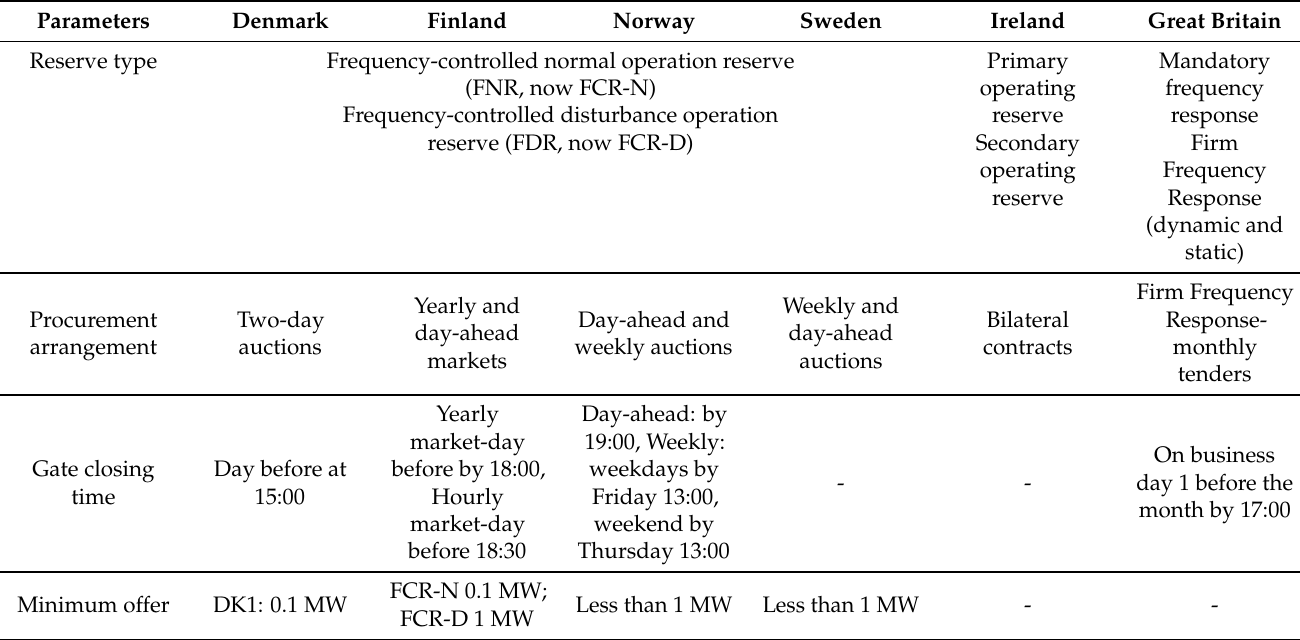
Table 1. Summary of FCR services unified under the ENTSO-E classification, including Nordic countries, Ireland and Great Britain. Parameters